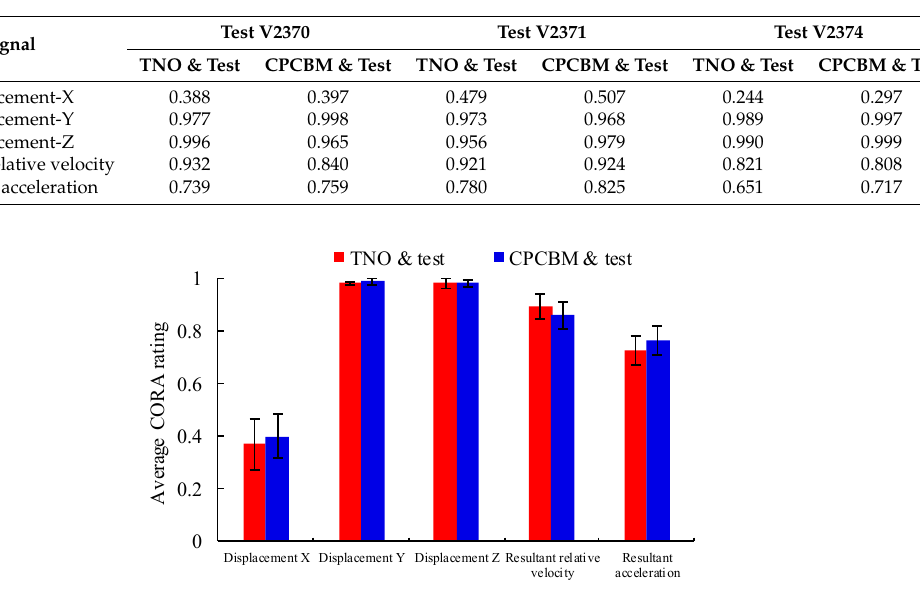
Table 3. Detailed CORA rating scores (S cora ) between simulations and experimental results.